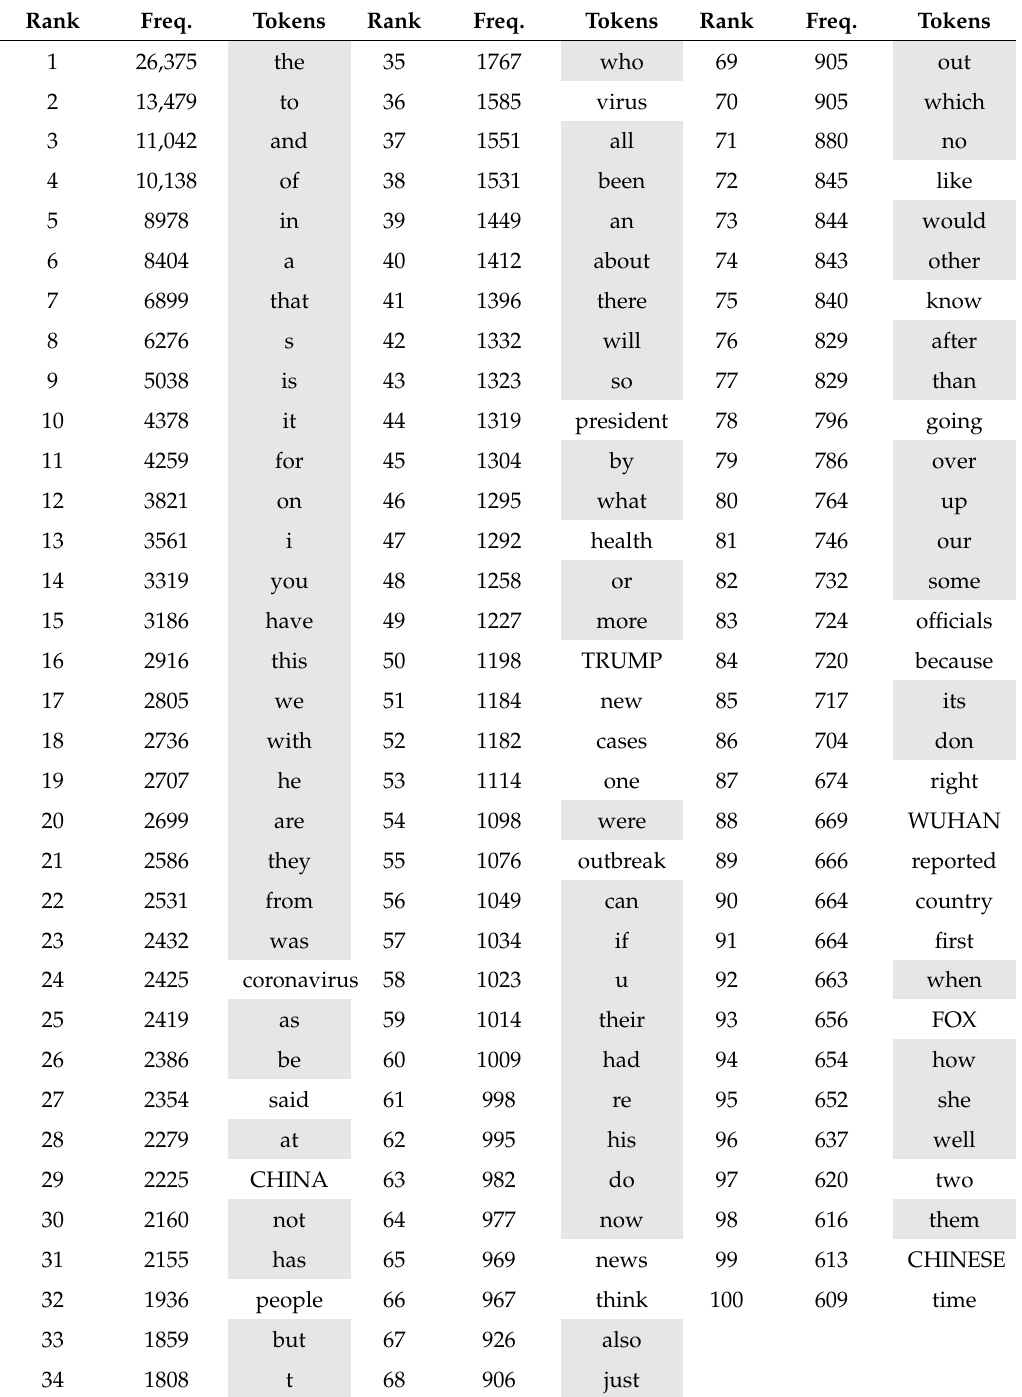
Table 2. An example of the word list from the input corpora (partial